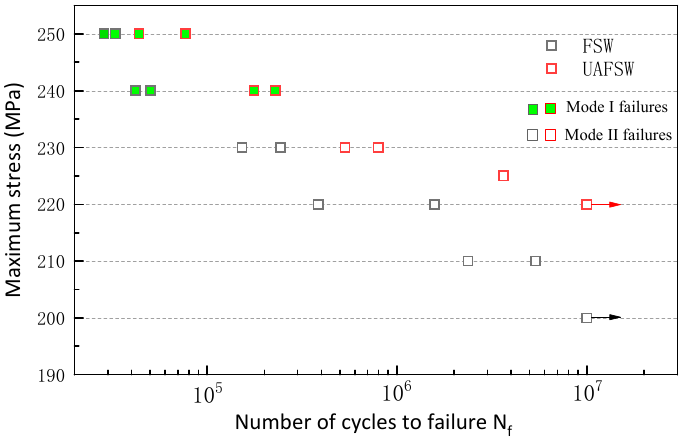
Figure 7. S–N diagram of the FSW and UAFSW specimens.